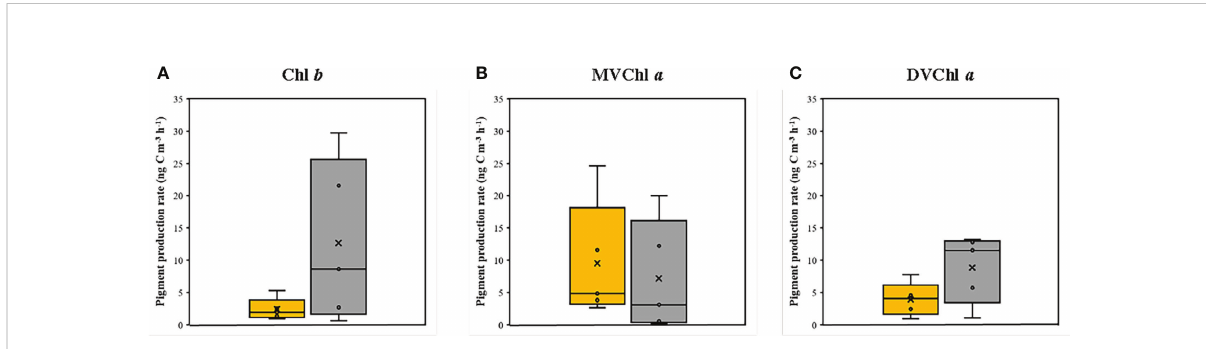
FIGURE 4 The production rates of (A) Chl b, (B) MVChl a and (C) DVChl a between the two light depths. Yellow and gray boxes represent 100 % and 1 % light depths, respectively. The abbreviations of pigment are shown in Table